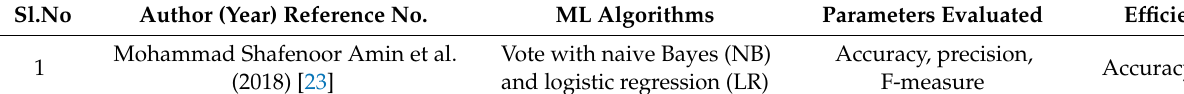
Table 3. List of various machine learning algorithms used for disease